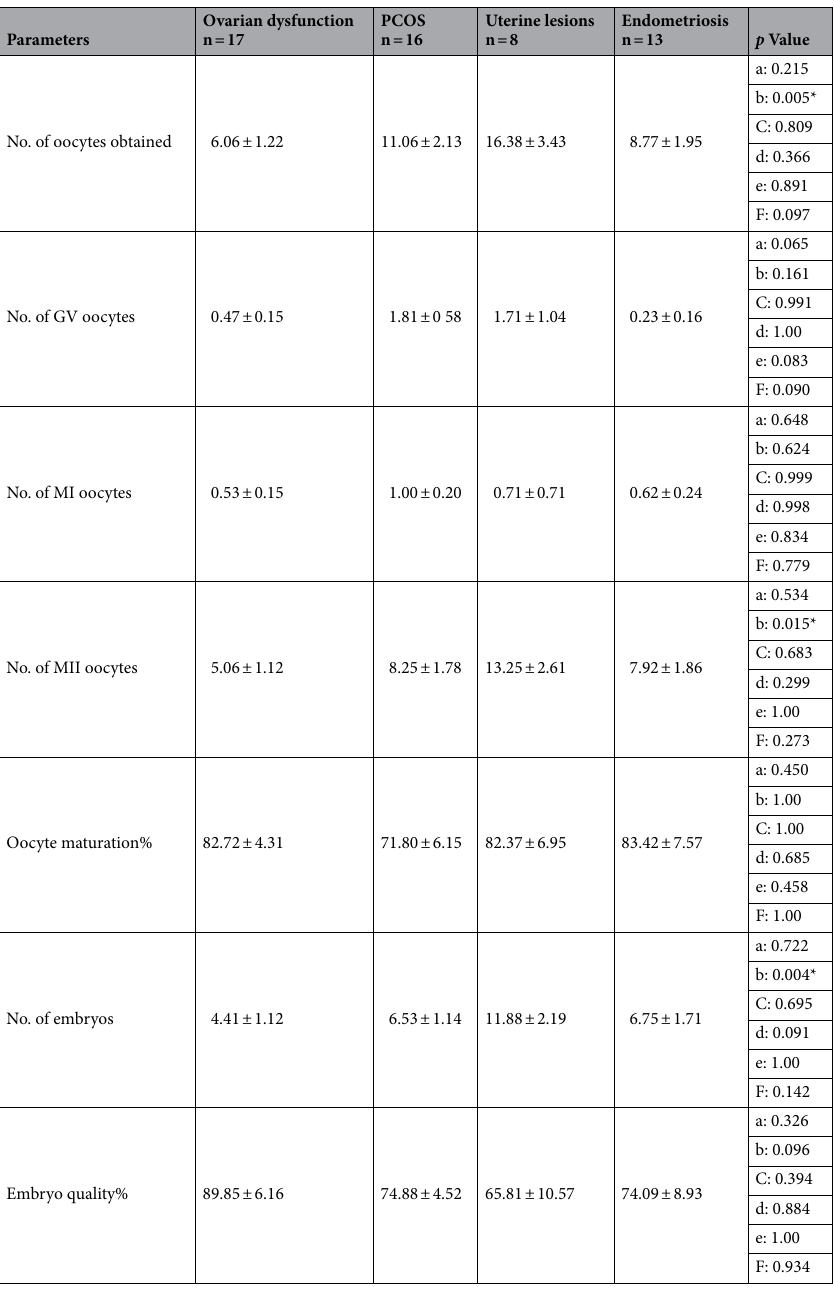
Table 2. Comparison of different parameters in four subgroups of the case group. Different parameters were compared between four subgroups of the case group, including Ovarian dysfunction, PCOS, Uterine lesions, and Endometriosis. The sing * indicates a significant difference on the Anova followed by the Tukey HSD post Hoc test (* p < 0.05). a: p value between Ovarian dysfunction and PCOS groups, b: p value between Ovarian dysfunction and Uterine lesions groups, c: p value between Ovarian dysfunction and Endometriosis groups, d: p value between PCOS and Uterine lesions groups, e: p value between PCOS and Endometriosis groups, f: p value between Uterine lesions and Endometriosis groups. The results are presented as the mean ± SEM. GV germinal vesicle oocyte, MI metaphase I oocyte, MII metaphase II